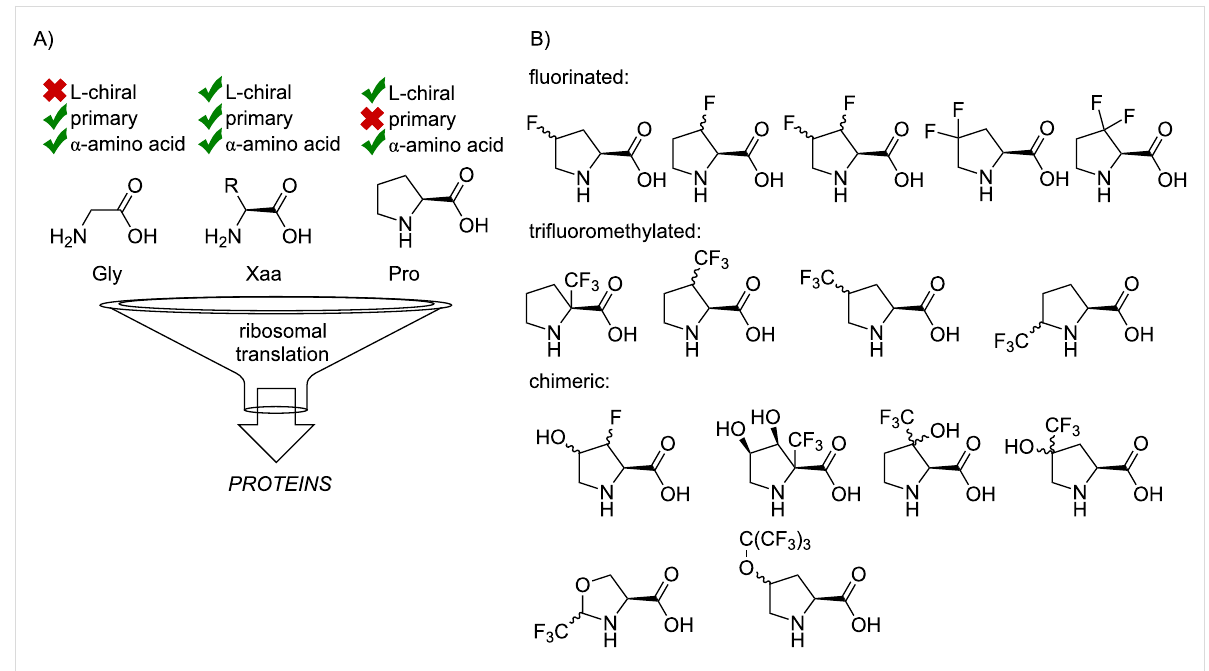
Figure 1: A) Three types of the backbone amino acid structures that are included in protein translation: glycine, alanine, and the set of its structural derivatives, proline. B) The portfolio of the fluorinated amino acids developed to